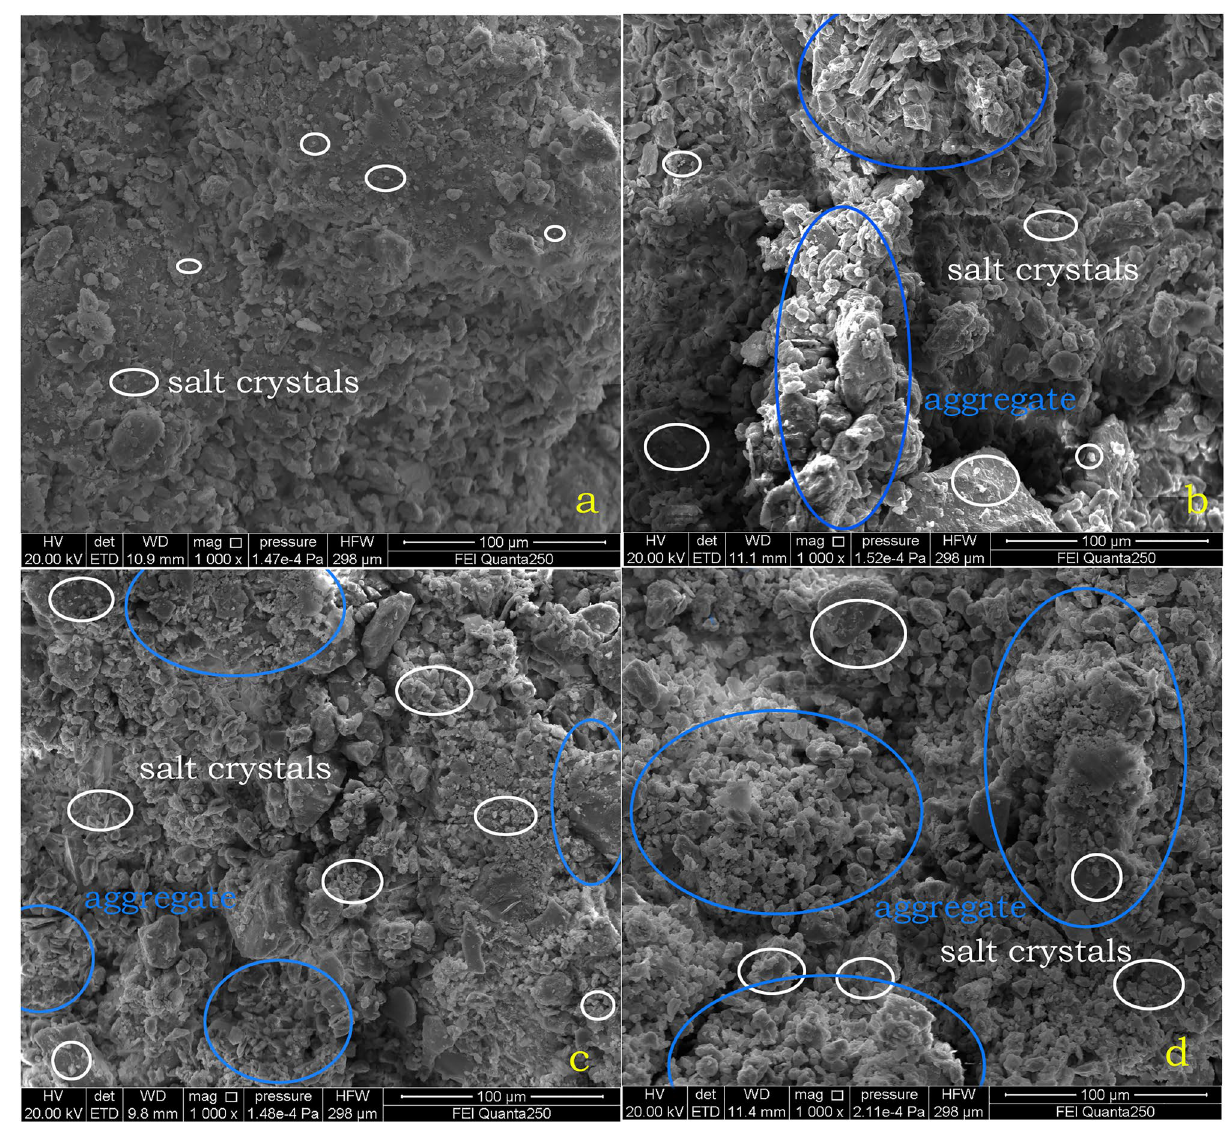
Figure 8. Results of the 4th, 10th, 15th and 20th electron microscope tests of 3% MgSO 4 : ( a ) 4th cycle; ( b ) 10th cycle; ( c ) 15th cycle; ( d ) 20th